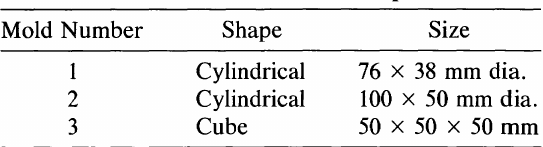
Table 1. Details of Molds Used in Experiments Mold Number